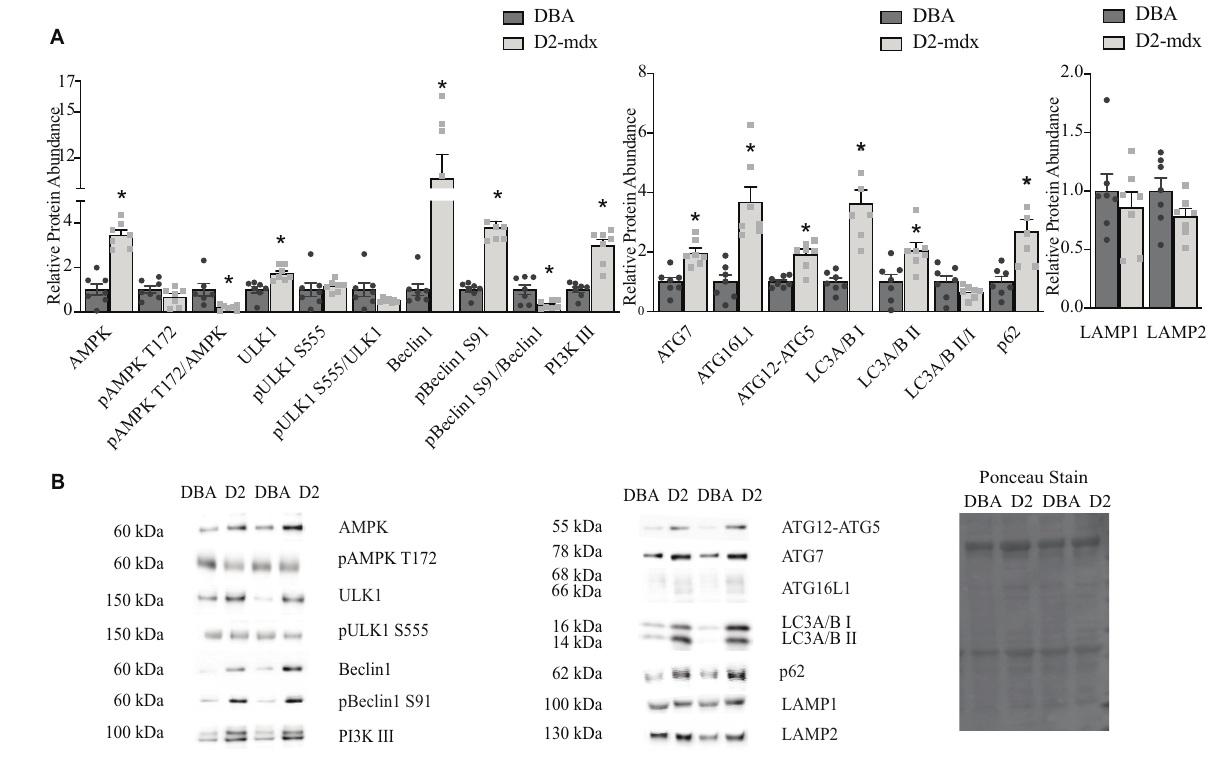
Frontiers in Physiology |